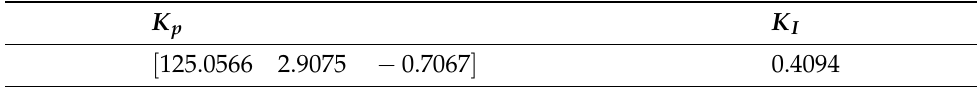
Table 4. Parameters of LMI stabilizing controller (Unit Circle).